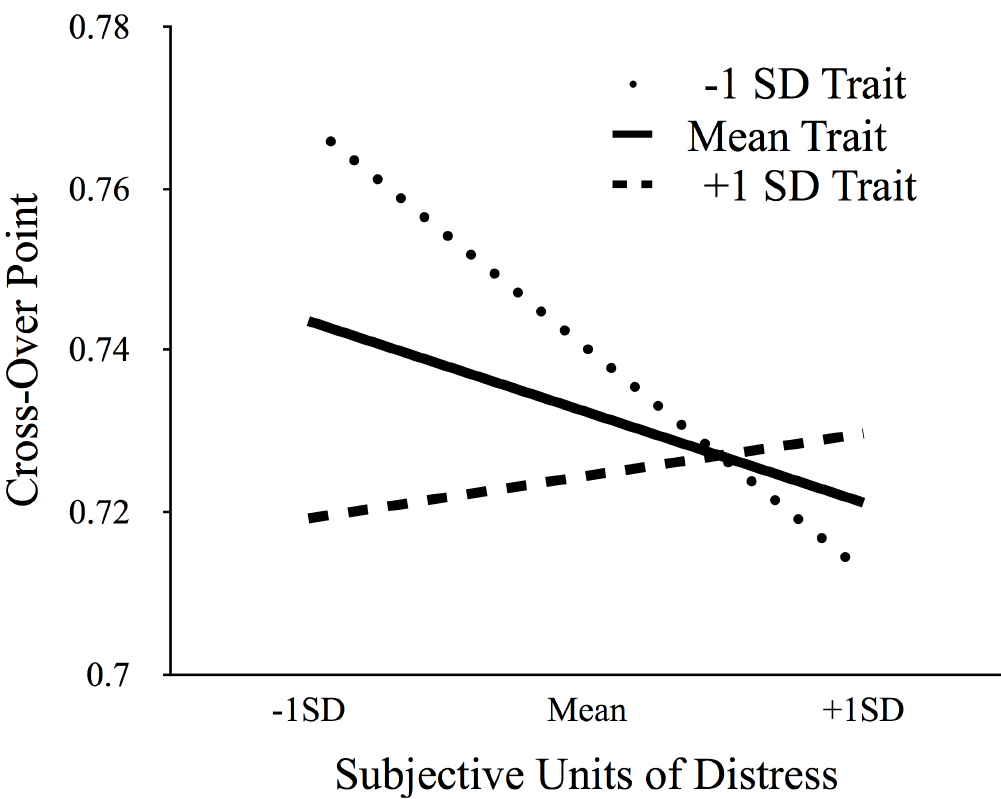
Fig 3. Cross-over Points as a Function of Fear. Cross-over points, or the largest gap at which participants stepped normed to eye-height, is plotted against state levels of fear (mean, +/- 1SD) for three values of trait fear (average, +/-1SD indicates high or low). Higher trait individuals were cautious, opting to step across only relatively smaller gaps. Lower trait fear individuals acted more cautiously when experiencing higher state fear than when experiencing lower state